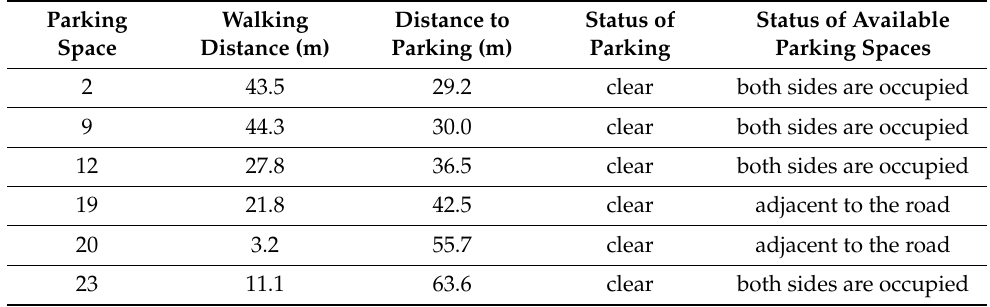
Table 3. Properties of the available parking spaces in the parking lot of scenario